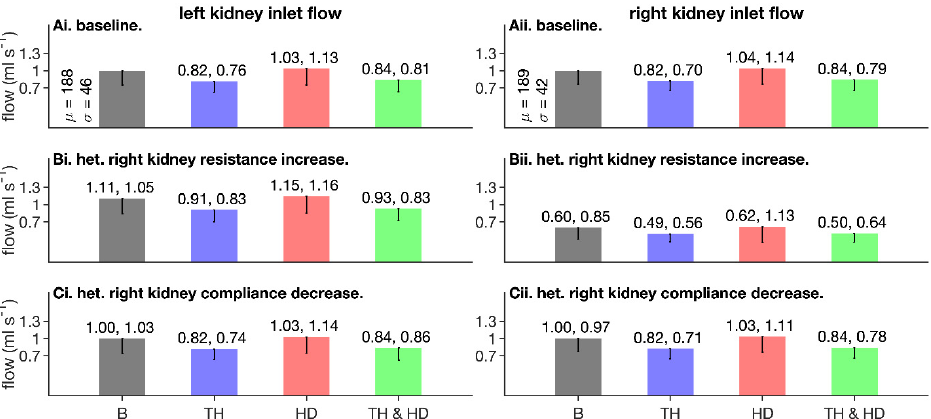
Figure 8. Effects of heterogeneous right kidney failure on renal inlet flow. Left column shows data for left kidney and right column shows data for right kidney. Top row shows data for control (absence of right kidney failure), middle row shows data when half of the right kidney microvascular resistances were increased 10 fold, and bottom row shows data when half of the right kidney microvascular compliances were reduced (i.e., stiffness was increased) by 90%. See Supplementary Materials, Figure S1 for the model’s kidney structure. In all panels, (B gray bars) represents baseline model outputs, TH (blue bars) represents model outputs under therapeutic hypothermia, HD (red bars) represents hemodialysis, and HD&TH (green bars) represents simulation application of hemodialysis and therapeutic hypothermia. The mean values ( μ ) and standard deviations ( σ ) for baseline (B, gray bars) are provided in panel ( Ai ). The mean values and standard deviations relative to the respective baseline values shown in ( Ai ) are provided for TH, HD, and TH&HD cases in all panels.